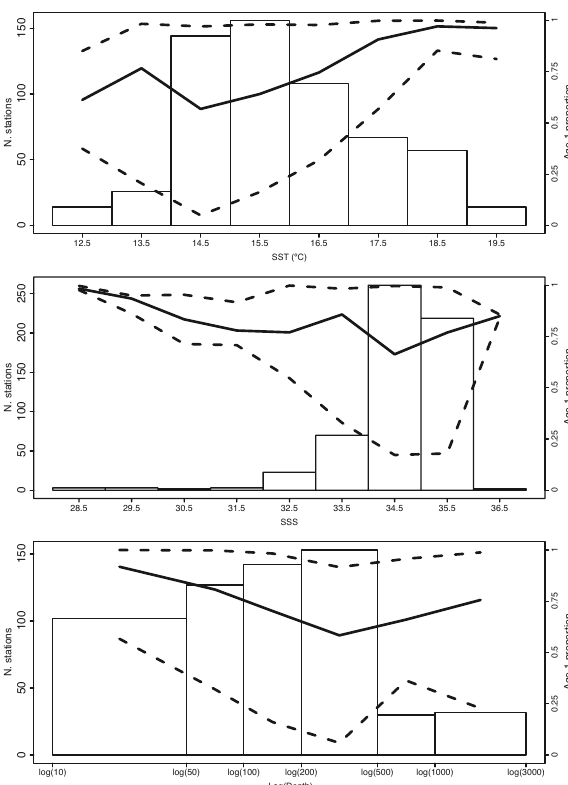
Fig . 2. – Number of stations (vertical line) and distribution of age-1 individuals (lines) in relation to sea surface temperature, sea surface salinity and the logarithm of bottom depth. The solid and dashed lines represent the median age-1 proportion and the 90% probability intervals, respectively. The depth classes are defined by the 0, 50, 100, 200, 500, 1000 and 3000 break points.